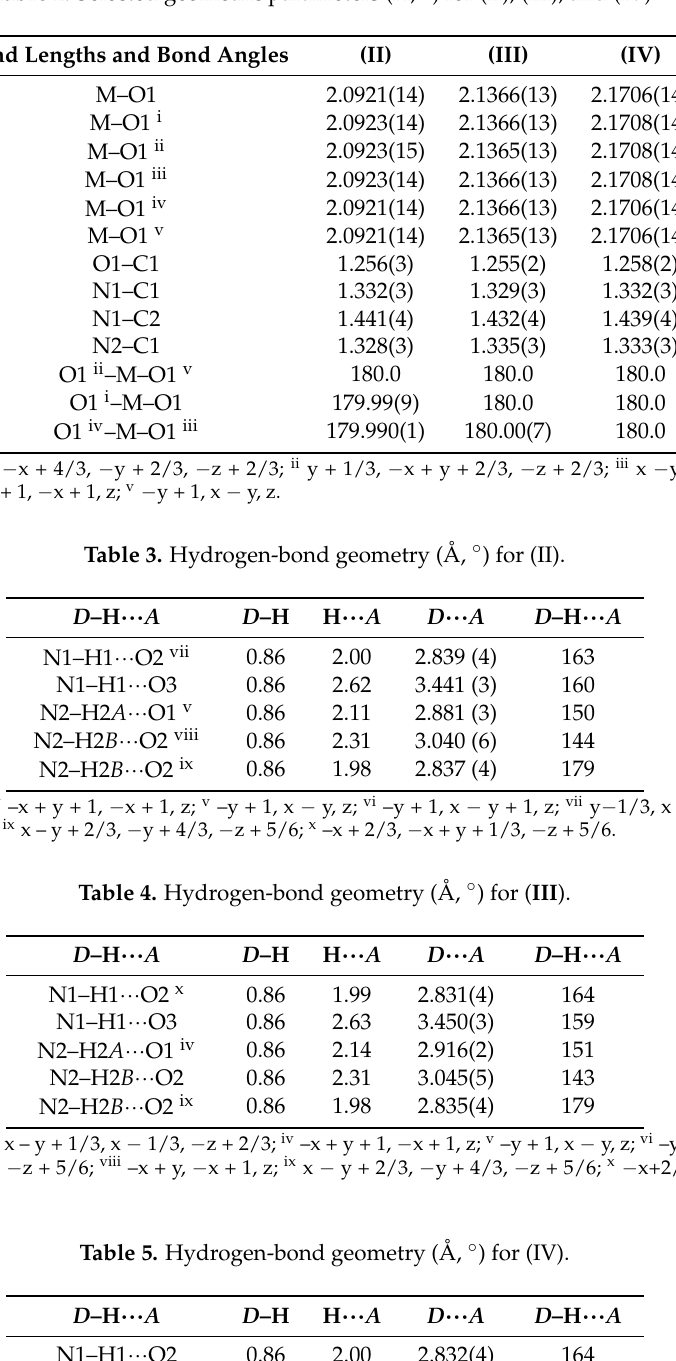
Table 2. Selected geometric parameters (Å, ◦ ) for (II), (III), and (IV).